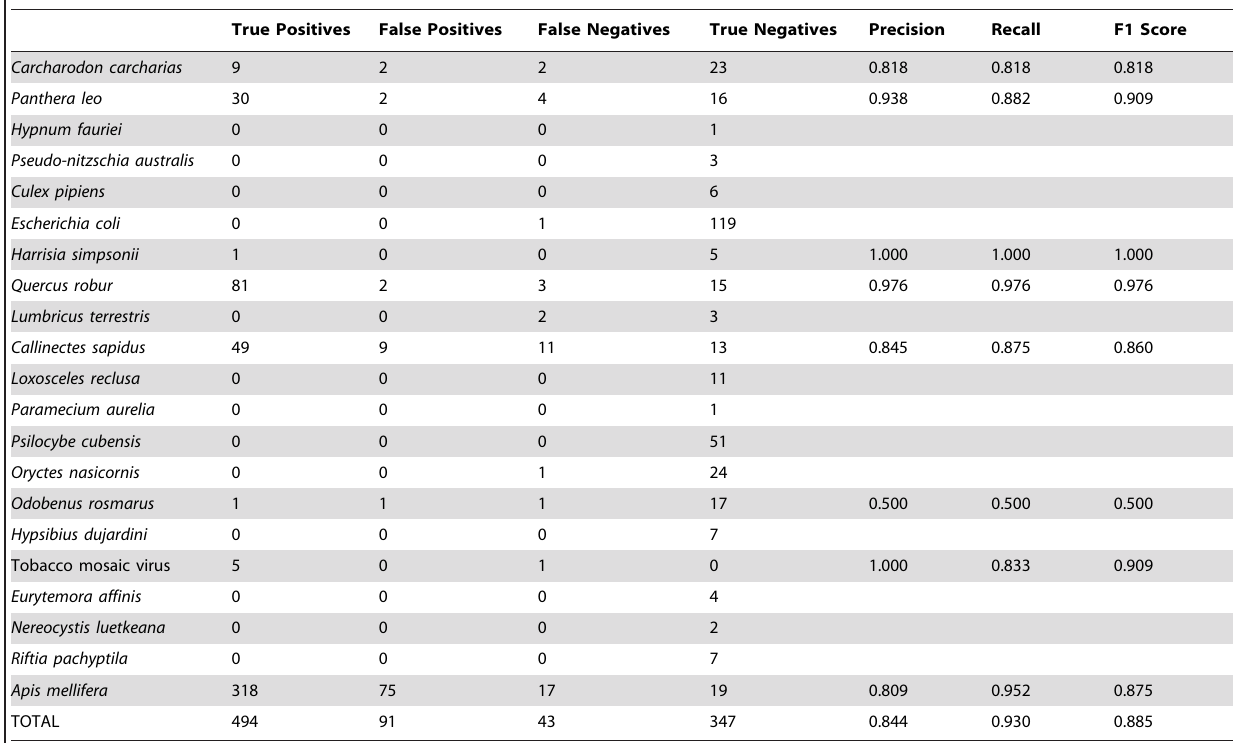
Table 3. Performance Metrics for Associations